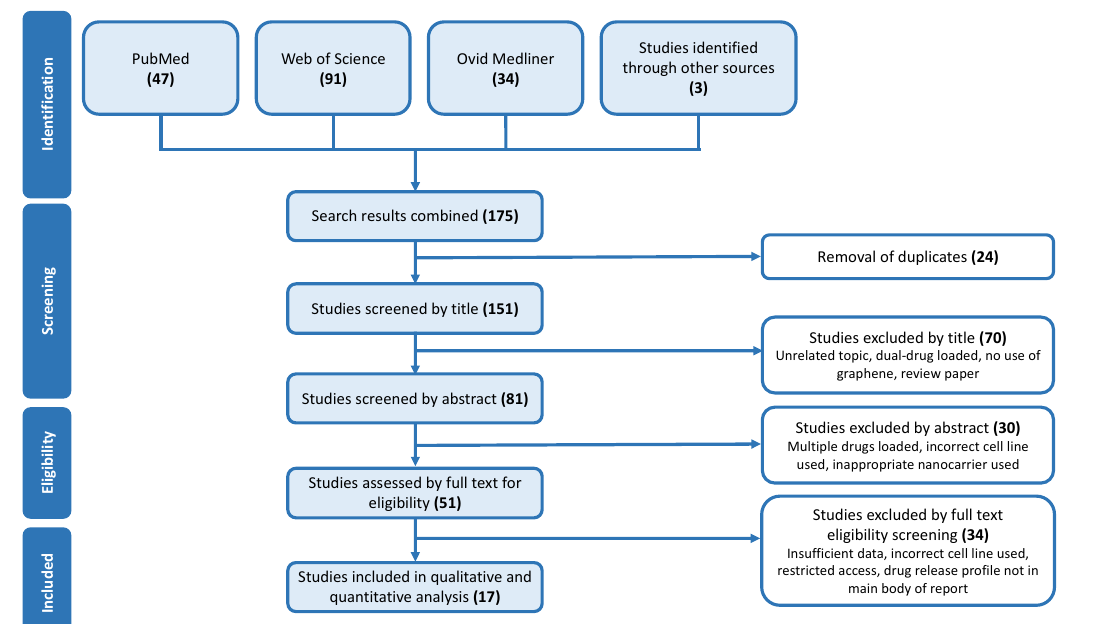
Figure 3. A systematic search and inclusion flowchart from the search engines PubMed ® , Web of ScienceTM, and Ovid Medline ® . Studies were all screened by title, abstract, and by full text to assess their eligibility. A total of seventeen studies were included for analysis based on the predefined inclusion and exclusion criteria.